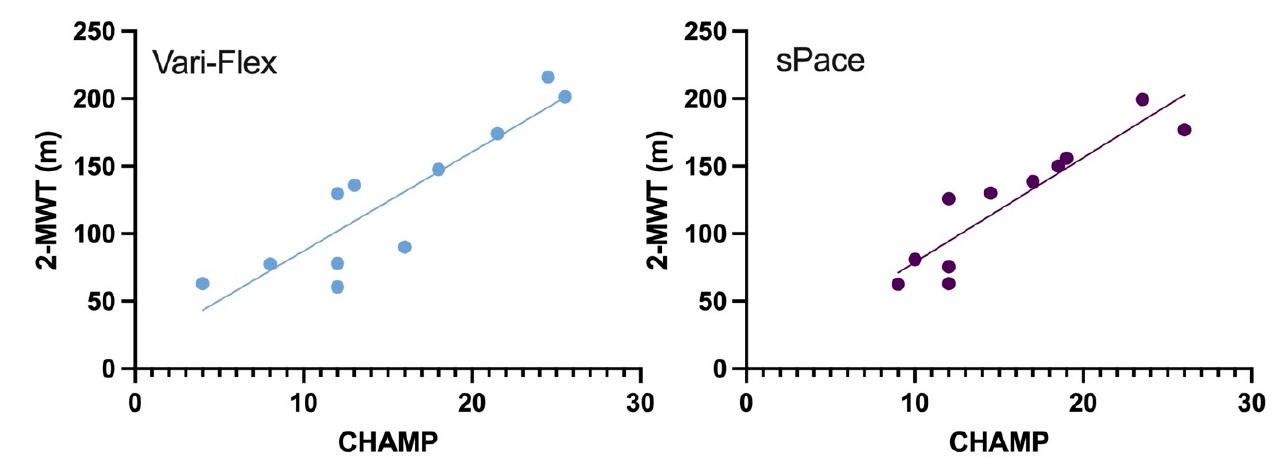
Figure 5. Pearson correlation coefficient between 2-MWT and CHAMP for sPace and Vari-Flex. Note: 2-MWT: two-minute walk test, CHAMP: Comprehensive High-Level Activity Mobility Predictor. The 2MWT units are in meters, and CHAMP units are summed scores of battery of outcome